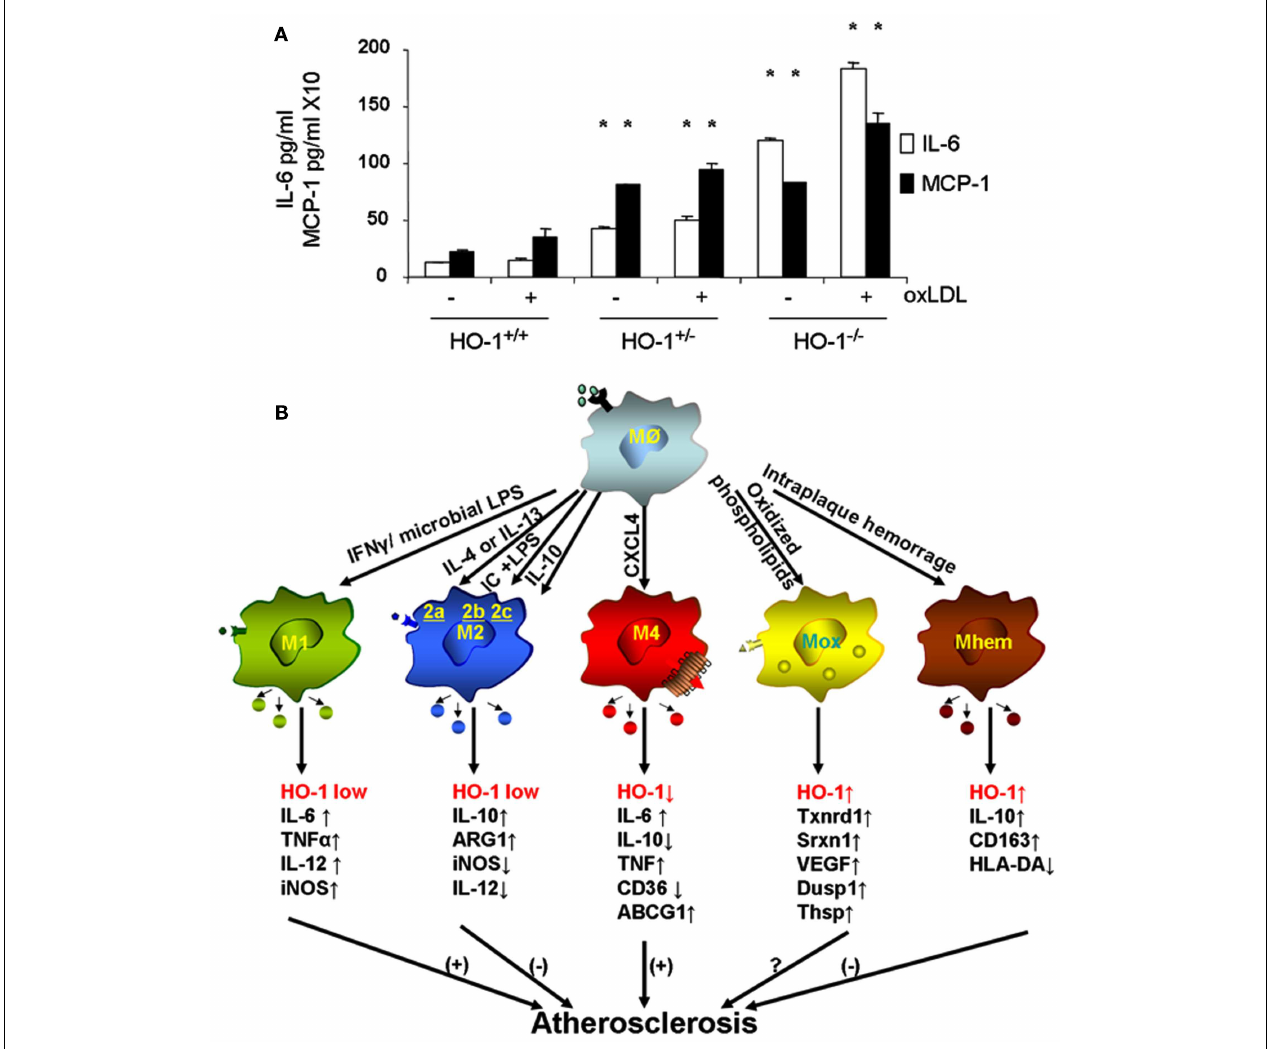
subtype is induced by specific stimuli as shown along the arrows that derive from the macrophage Mø atop, and characterized by a set of phenotypic markers and/or gene expression shown below each one of them.While some of macrophage subtypes are proposed to simulate atherogenesis such as M1 and M4, others are proposed to inhibit lesion development such as M2 and Mhem. Mox macrophages, generated after treatment with oxPAPC, are dependent on Nrf2 with a role in atherogenesis still to be